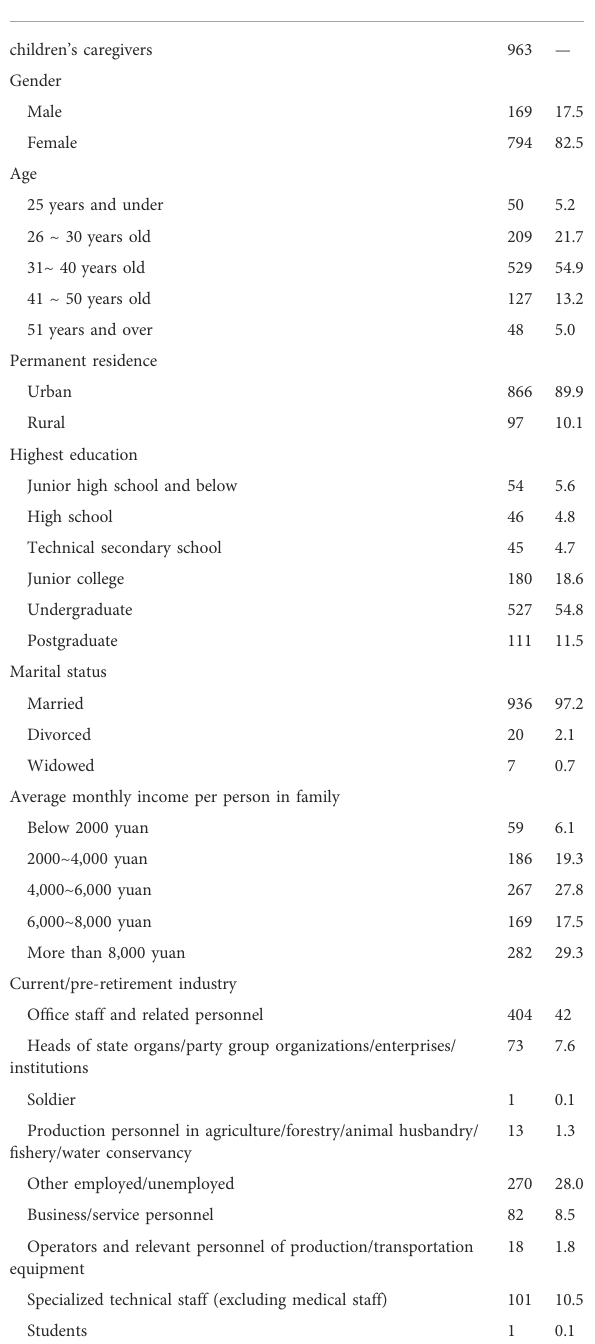
TABLE 1 Sociodemographic characteristics of the children ’ s caregivers ( n =